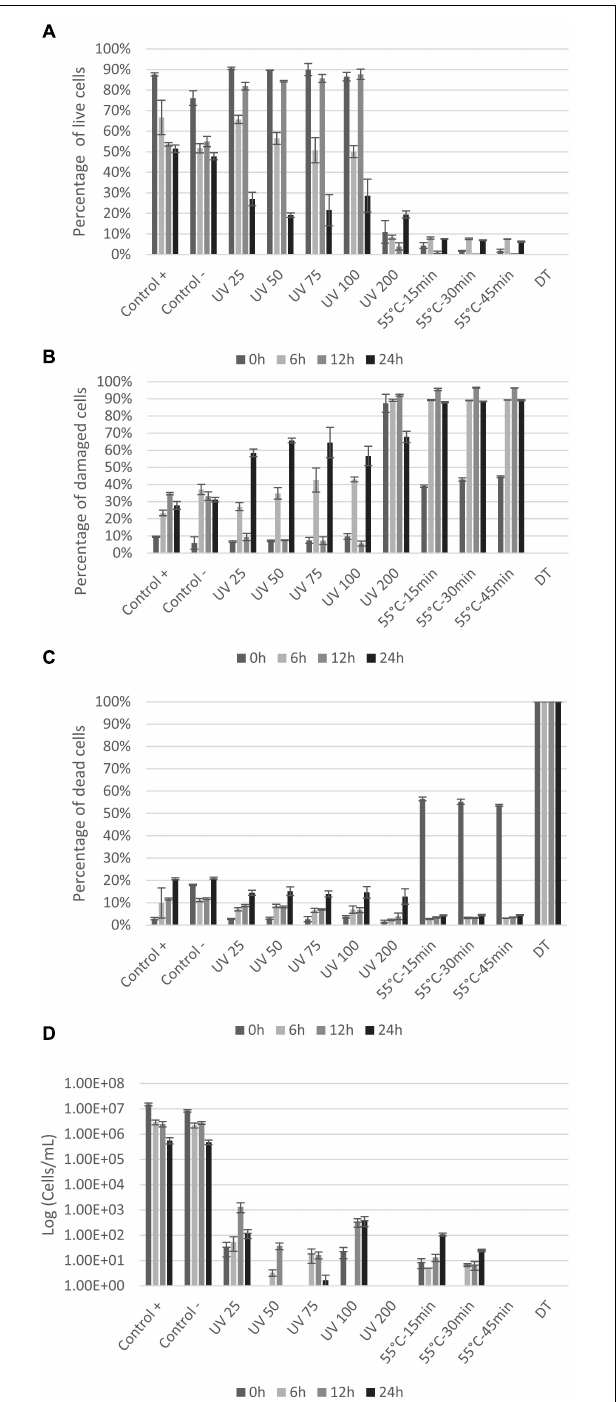
TABLE 1 | Overview of bacterial vitality states with BONCAT–SYBR Green. Quadrant SYBR Green BONCAT Physiological